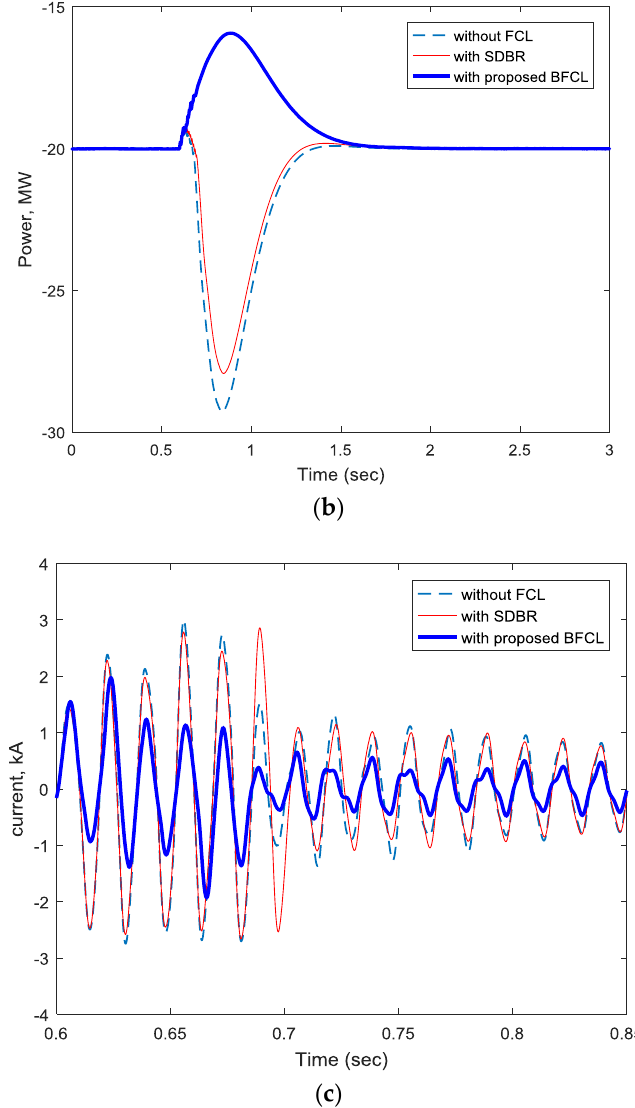
Figure 9. Comparative transient response of two grids connected VSC-HVDC system subject to 2LG fault at grid1 ( a ) DC link voltage ( b ) Grid1 active power flow ( c ) Phase ‘a’ current of grid1.